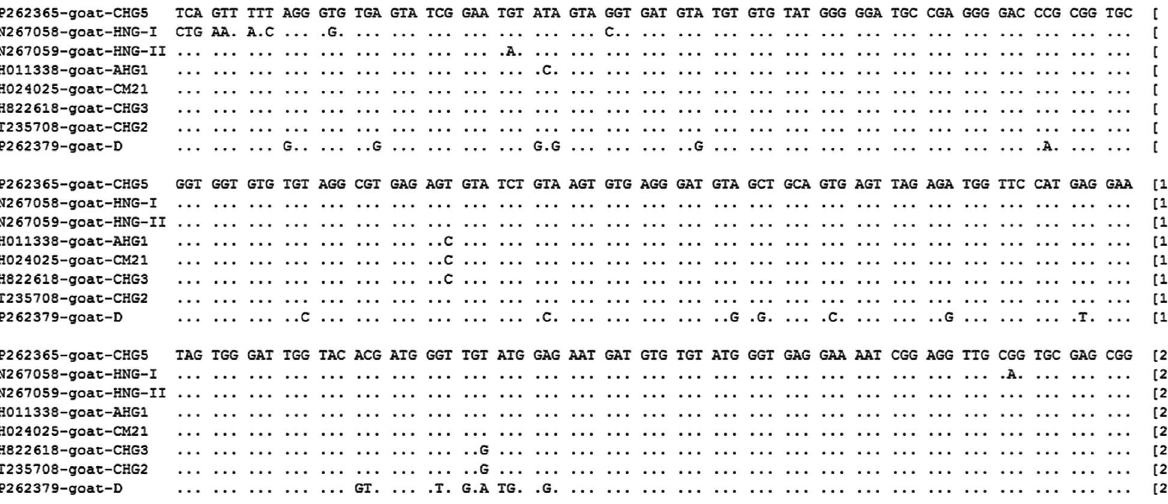
Figure 2. Sequence variation in the ITS region of the rRNA gene of E. bieneusi isolates identi fi ed in black goats. Dots indicate the same base identity as the ITS gene sequence of genotype